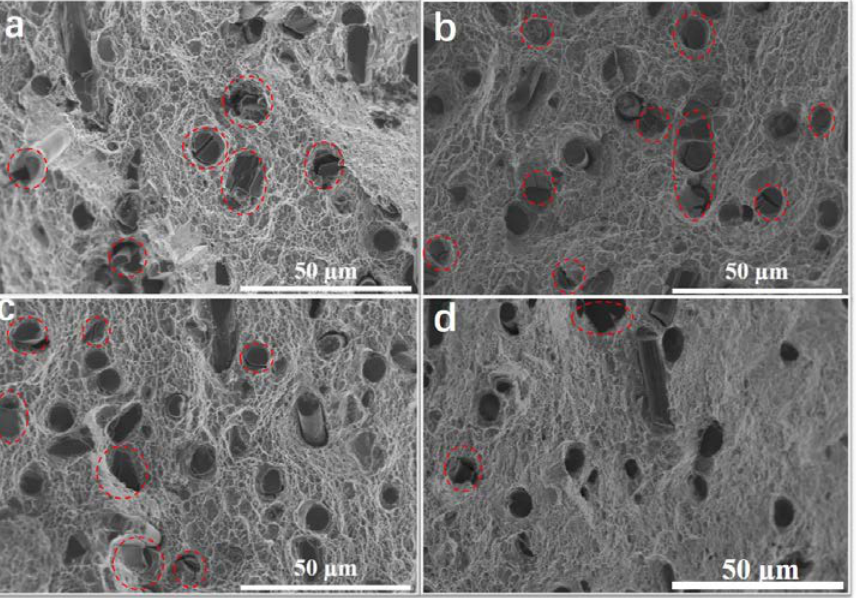
Figure 9. Typical morphologies fracture surface of SCFs/2024 Al. ( a ) thermal exposure time 0 h; ( b ) thermal exposure time 0.5 h; ( c ) thermal exposure time 1 h; ( d ) thermal exposure time 500 h. Red dotted line area is the cut carbon fiber.